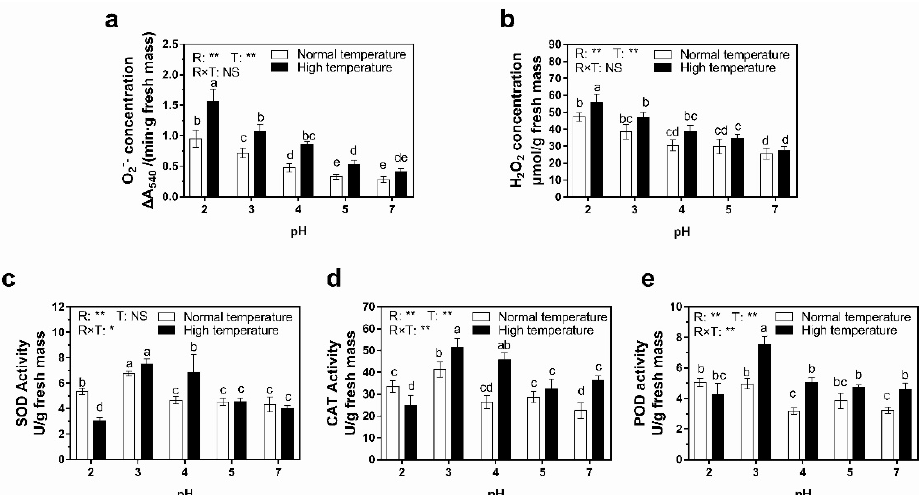
Figure 4. Effect of simulated acid rain and ambient temperature on the activities of antioxidant enzymes and concentrations of reactive oxygen species (ROS) in rice leaves after a 7-day treatment. ( a ) Superoxide anion (O 2 − ) concentration. ( b ) Hydrogen peroxide (H 2 O 2 ) concentration. ( c ) Superoxide dismutate (SOD) activity. ( d ) Catalase (CAT) activity. ( e ) Peroxidase (POD) activity. The columns with the same letter in each panel indicate an insignificant difference among different treatments ( p < 0.05). The p values of two-way ANOVA for rain pH (R), temperature (T) and their interaction (R × T) are shown: **, p ≤ 0.01; *, p ≤ 0.05; NS, p >